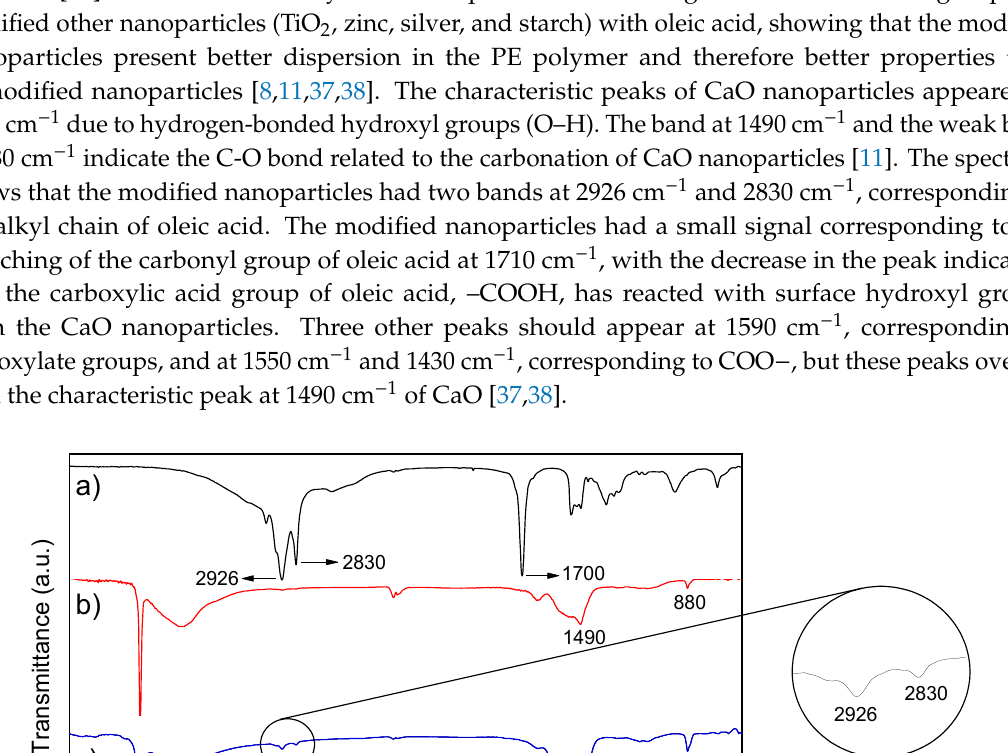
Figure 3. FTIR spectra of ( a ) oleic acid, ( b ) CaO nanoparticles, and ( c ) modified CaO nanoparticles.